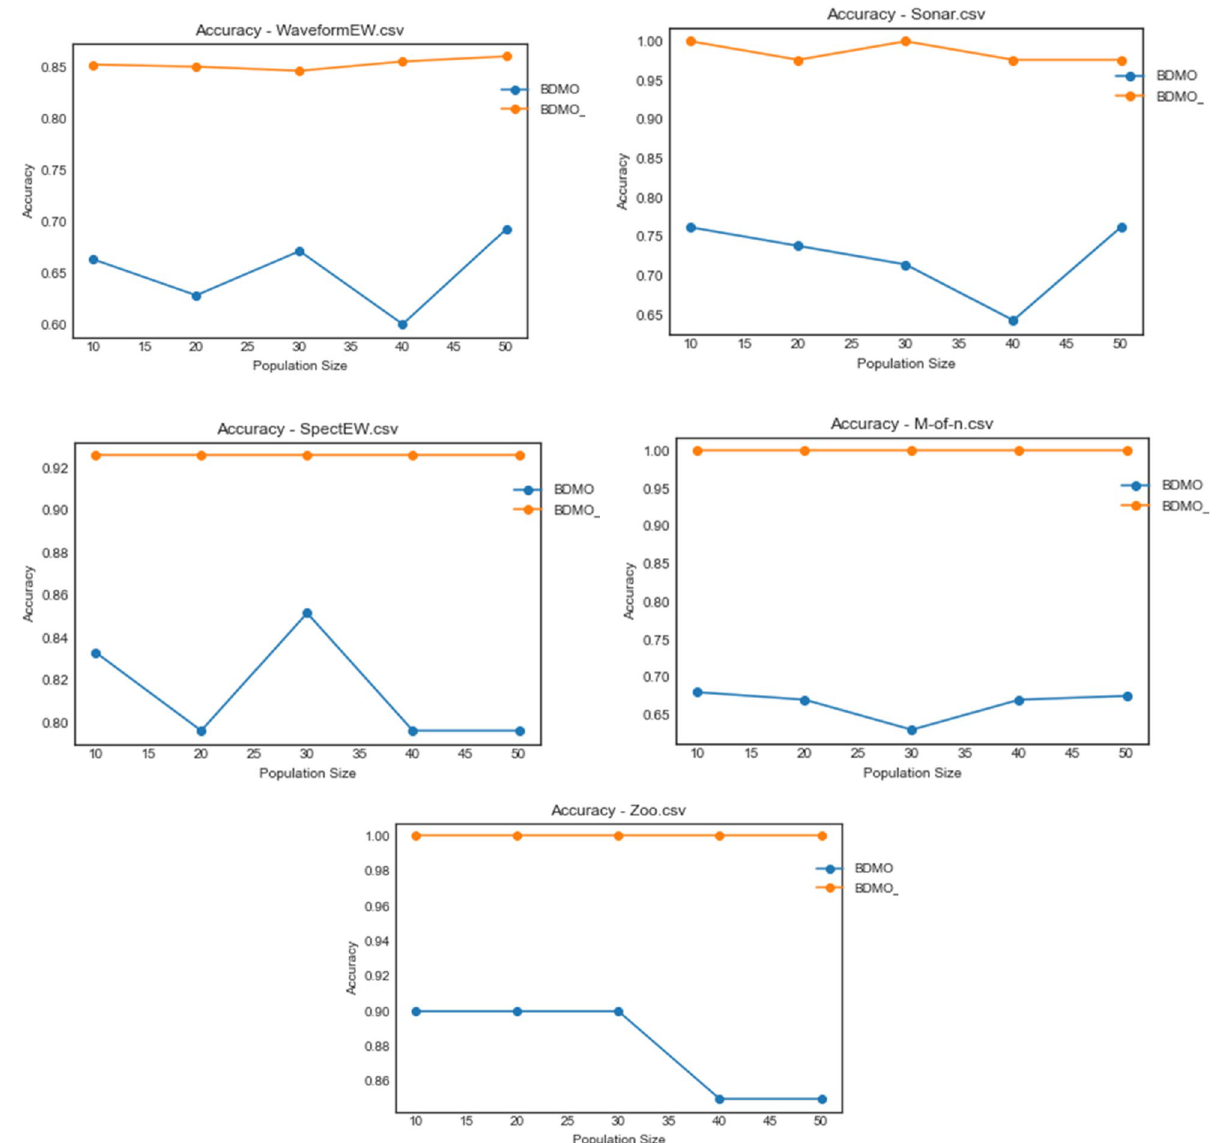
Figure 8. Accuracy plot of the BDMSAO and BDMO on waveformEW, sonar, SpaceEW, M-of-n, and Zoo